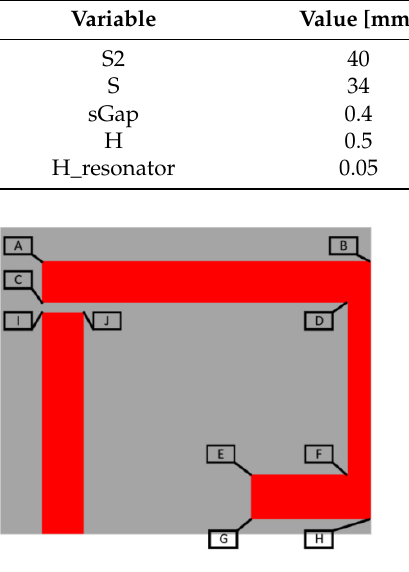
Figure 8. Labelled diagram for FE analysis.